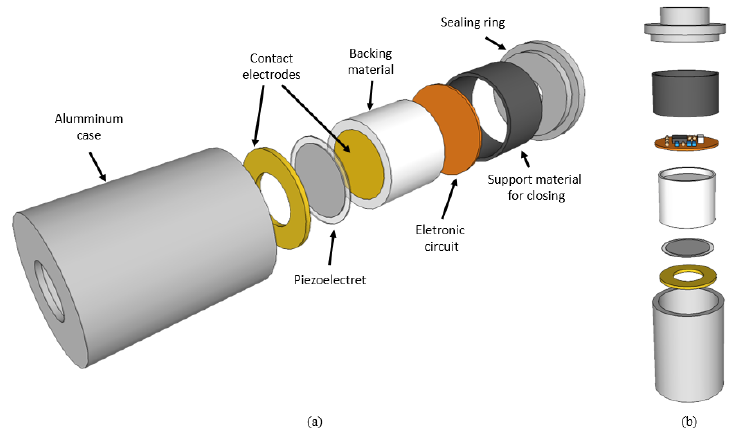
Figure 4. Acoustic transducer: design of the metallic enclosure, seen in perspective: ( a ) lateral; ( b )